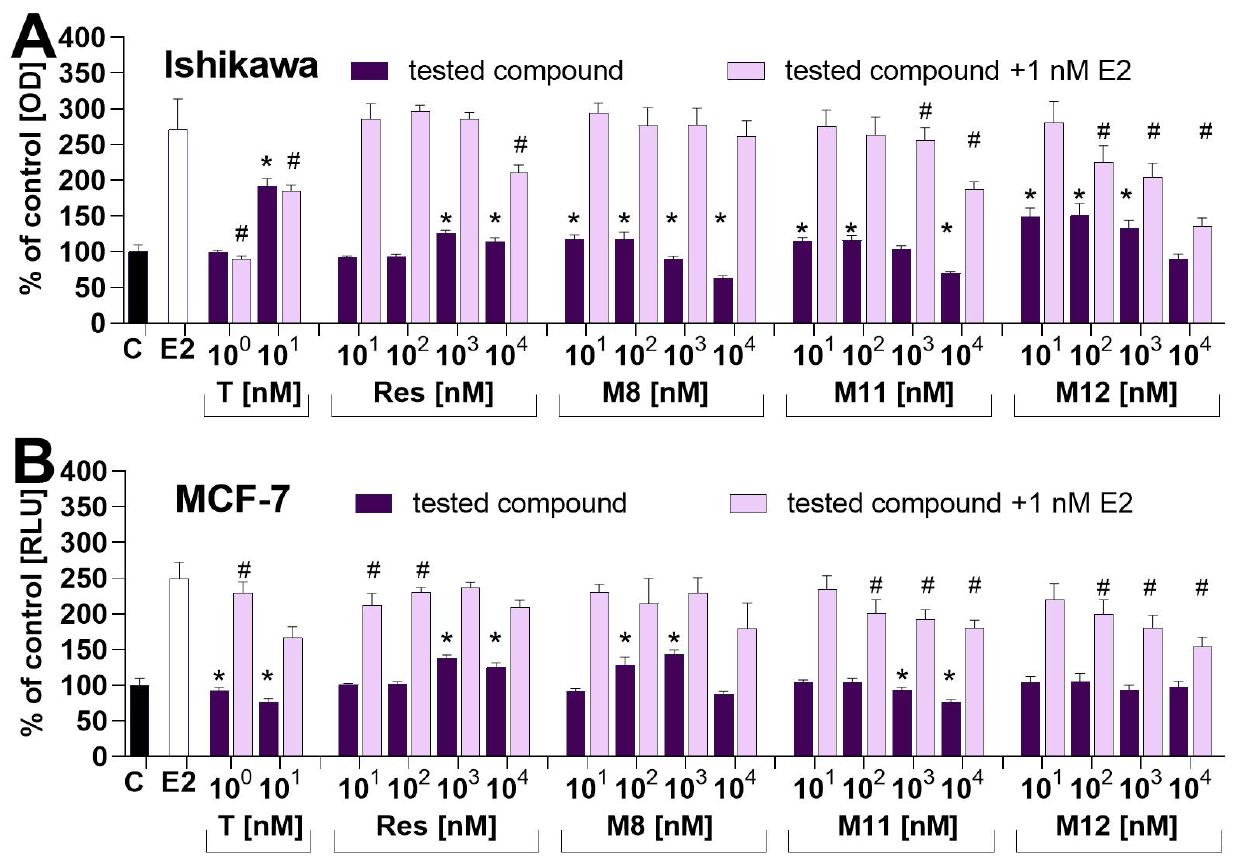
Figure 5. Dose–response of tested estrogen-dependent cancer cells. Cells were stimulated with: 1 nM estradiol (bar), tested compounds (light violet bars) and tested compounds incubated with 1 nM estradiol (dark violet bars) for 72 h. The control is illustrated by the black bar. ( A ) Proliferation of Ishikawa cells was measured by alkaline phosphatase activity. ( B ) Results obtained for MCF-7 cells; their proliferation was evaluated by fluorescence-based DNA measurements. The asterisks show a statistically significant difference between the control cells and cells stimulated by tested compounds: * p < 0.05. The pound symbol shows a statistically significant difference between cells incubated with 1 nM estradiol and cells incubated with 1 nM estradiol and tested compounds: # p < 0.05.